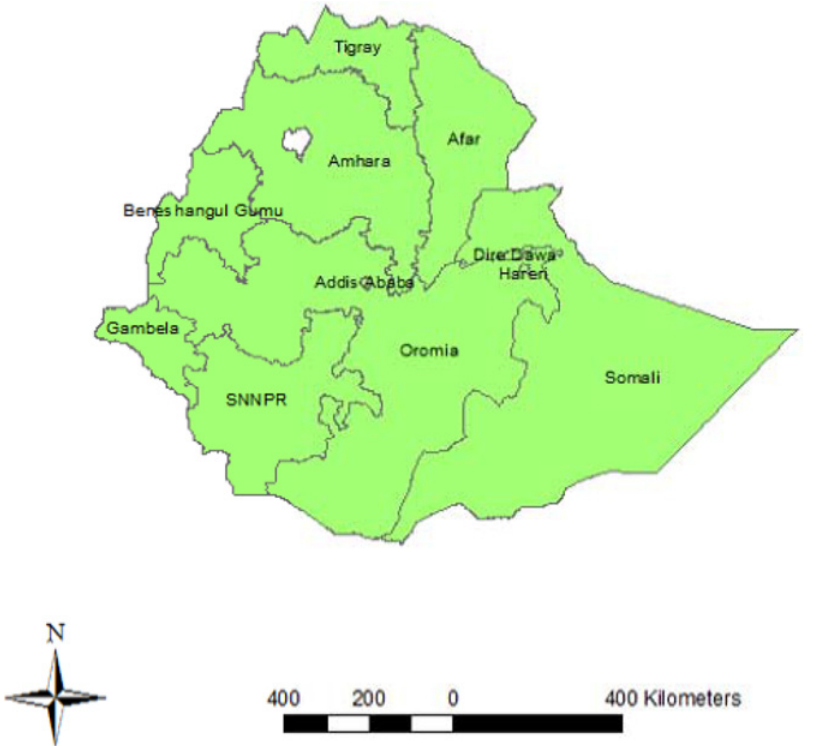
Figure 1. Regional States of Federal Democratic Republic of Ethiopia.